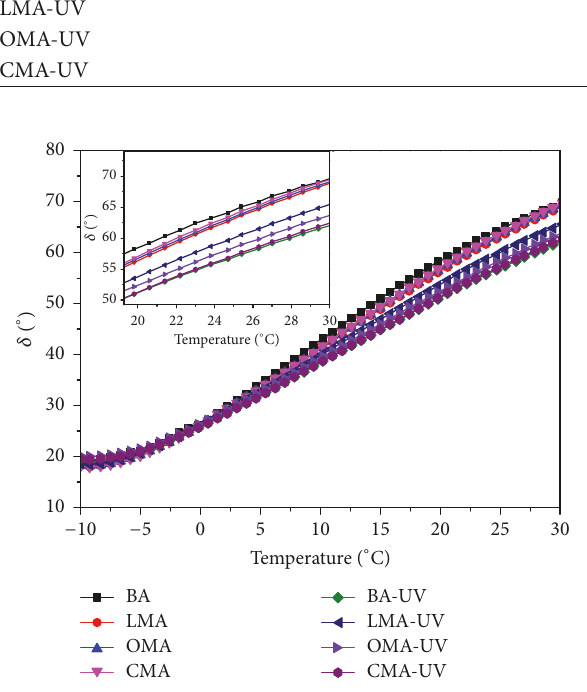
Figure 13: 𝛿 of UV aged and unaged asphalt from − 10 ∘ C to 30 ∘ C.